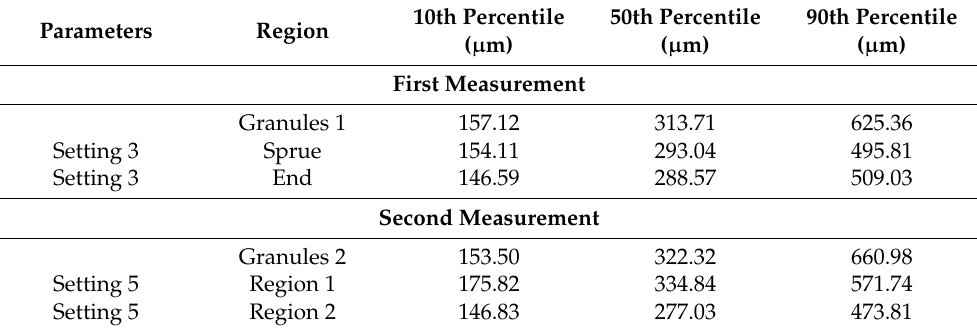
Table 8. Results of the fiber length characterization with dynamic image